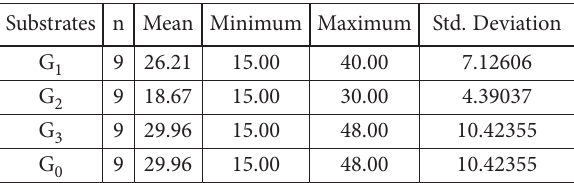
Table 7. Average number of leaves by substrates (number) Substrates n Mean Minimum Maximum Std. Deviation